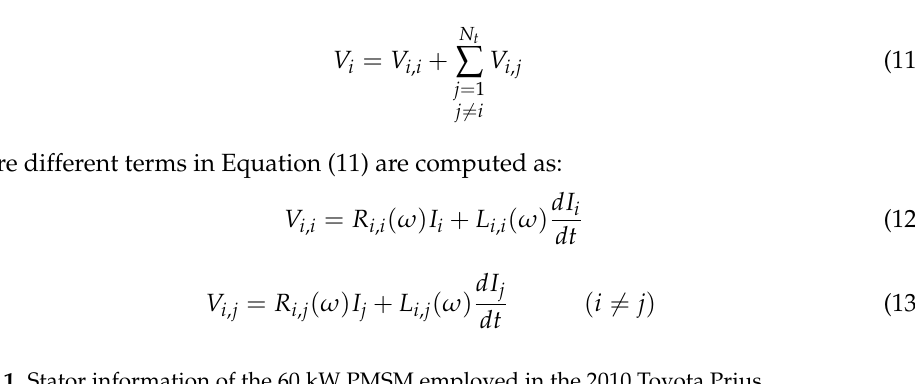
Table 1. Stator information of the 60 kW PMSM employed in the 2010 Toyota